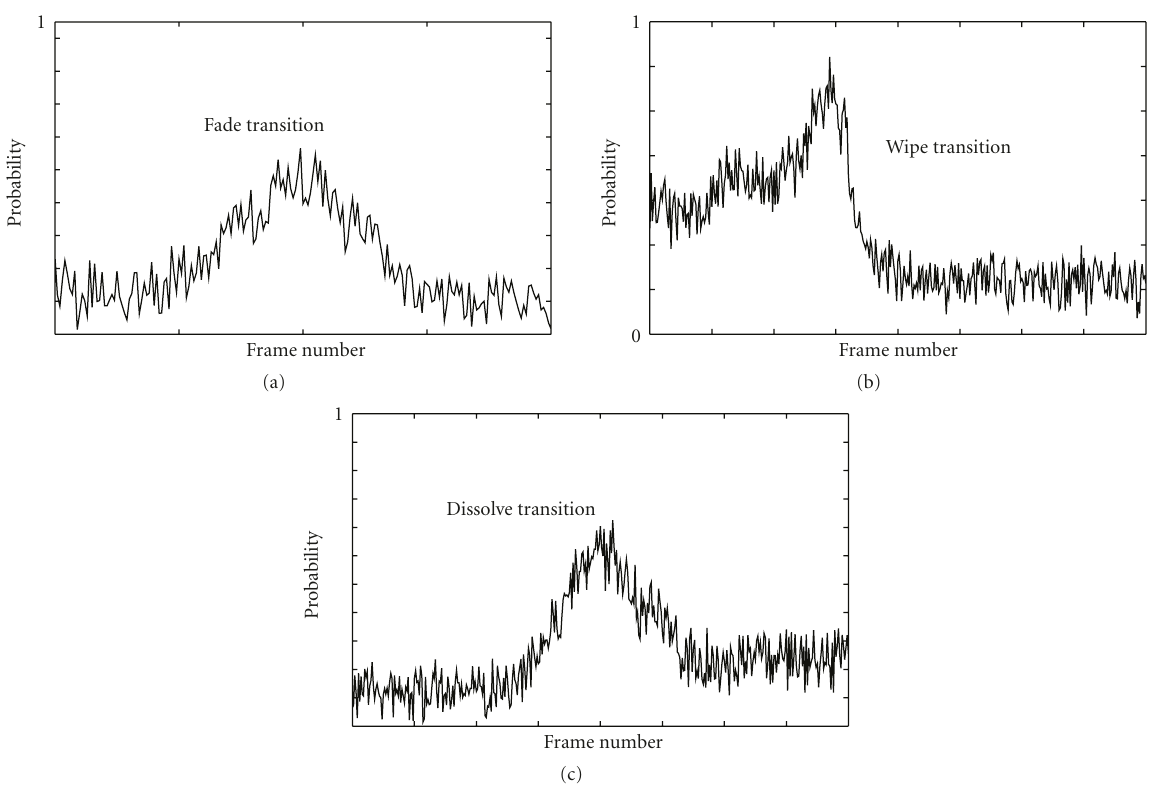
Figure 2: The plots of the probability function of (6) for some gradual shot transitions of di ff erent types.